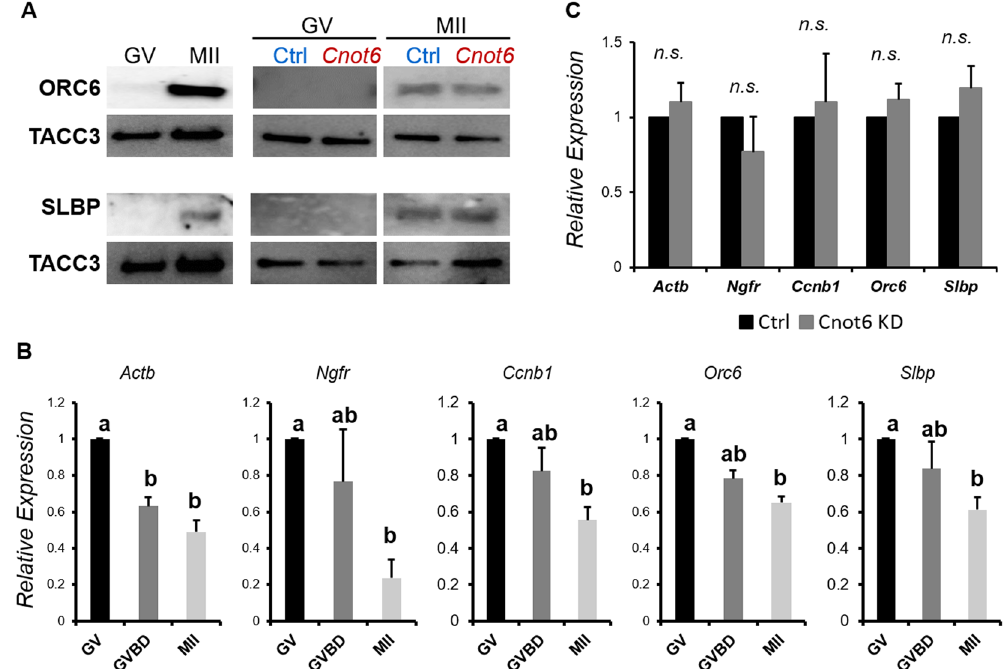
Figure 8. Increasing poly(A) tail-length does not affect mRNA translation or degradation. ( A ) Left: Immunoblot showing relative quantity of ORC6 and SLBP in immature (GV) and mature (MII) oocytes. TACC3 is a loading control. Right: Immature oocytes were injected with control (Ctrl) or Cnot6 siRNA and either maintained in the immature state (GV) or allowed to mature (MII), then immunoblotted. ( B ) Relative quantity of the indicated mRNAs at different stages of maturation. Data analysed using ANOVA with Tukey HSD; different letters above bars indicate statistically significant difference ( p < 0.05). ( C ) Relative quantity of the indicated mRNAs in mature oocytes following depletion of CNOT6 as in ( A ). Data analysed using t -test.